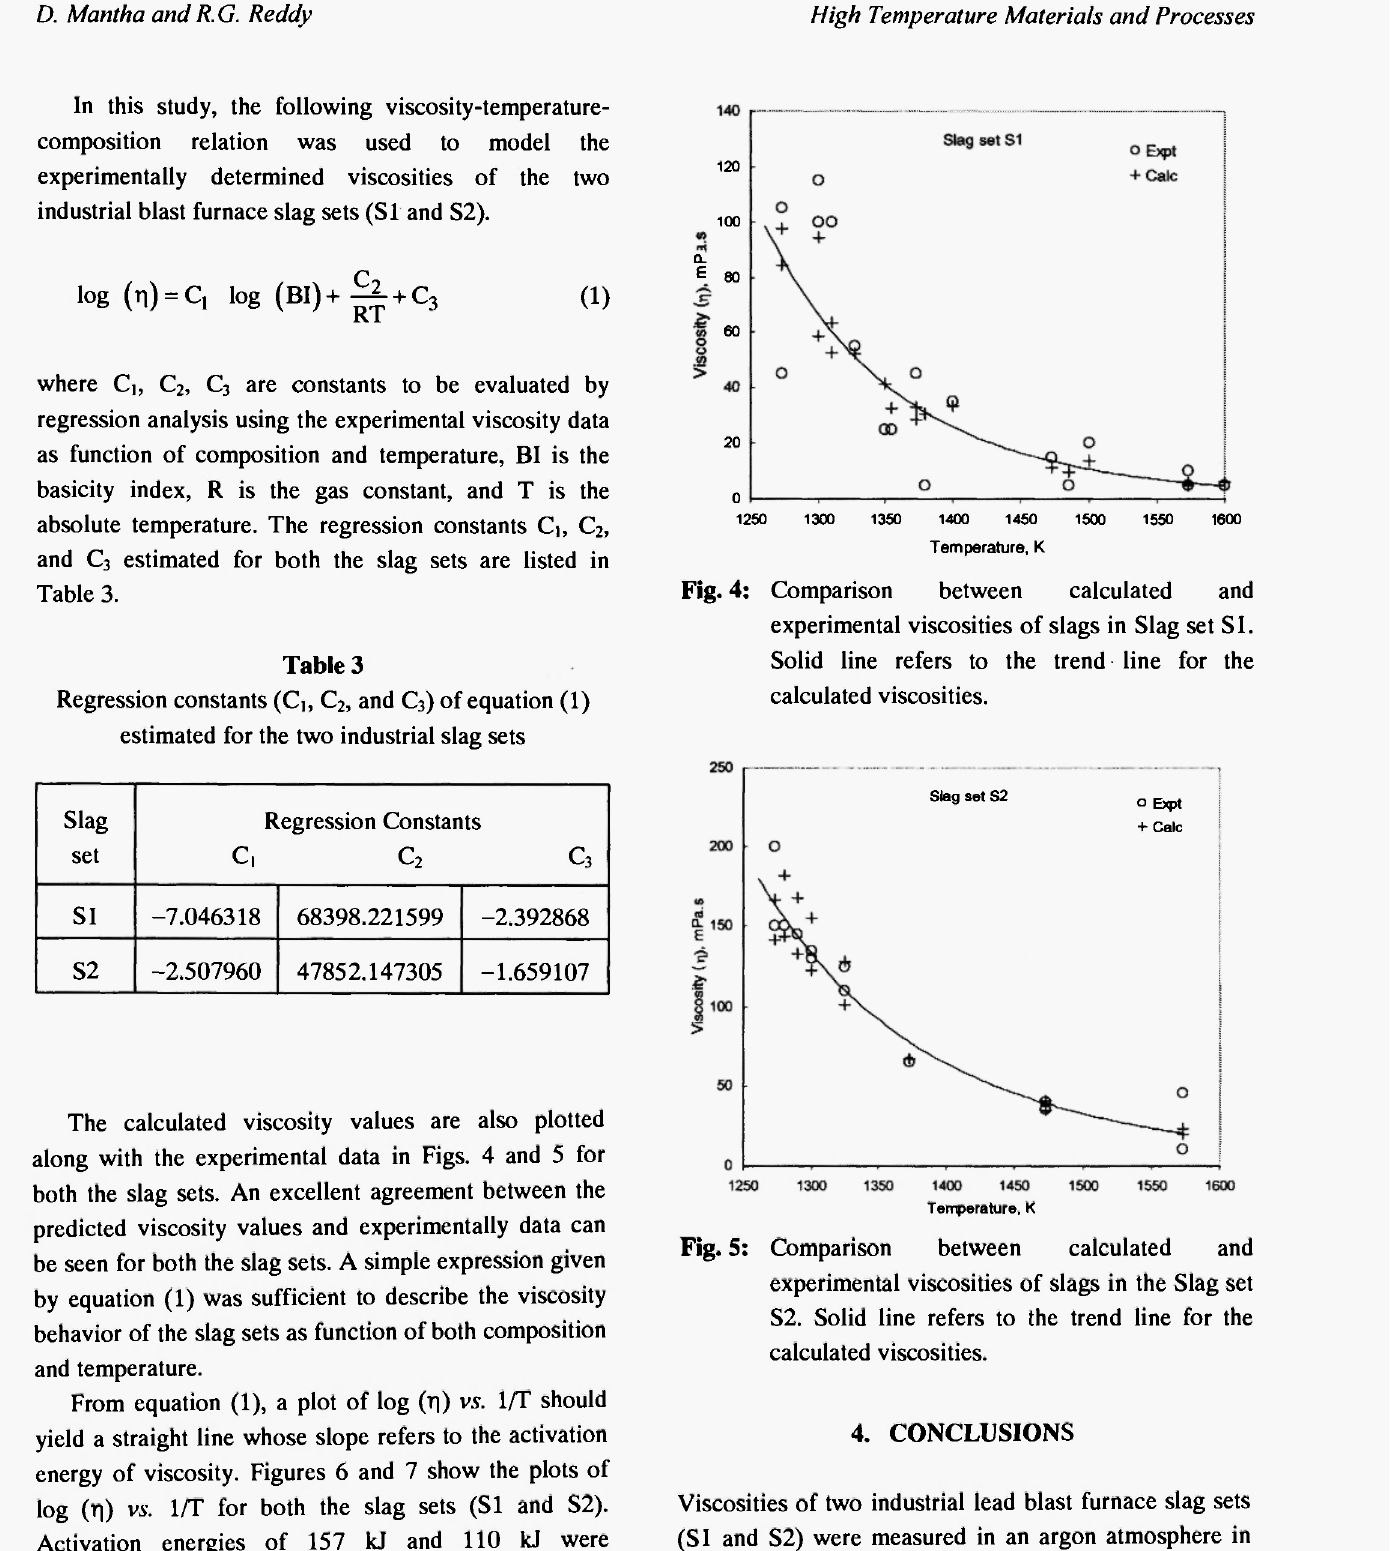
Fig. 5: Comparison between calculated and experimental viscosities of slags in the Slag set S2. Solid line refers to the trend line for the calculated